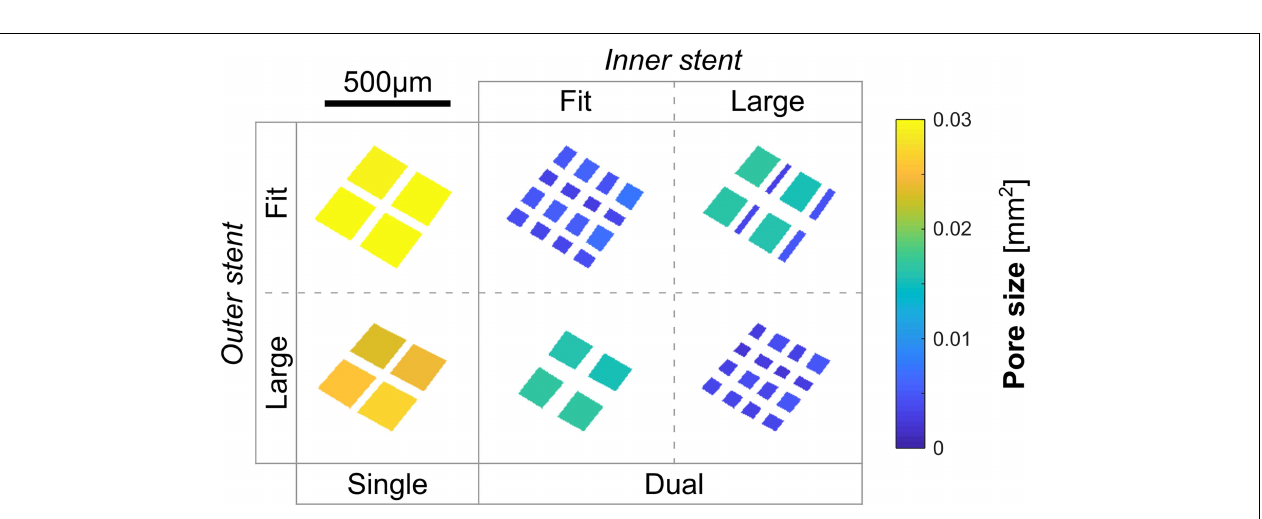
FIGURE 4 | The change in pore size (right) caused by deployment of a second stent shows good correlations ( r ≥ 0.50, all p < 0.001) with reductions of the post-treatment IR, aVEL, and aWSS, compared with the changes in porosity ( left , r < 0.15, all p > 0.24) and pore density (middle, r ≤ 0.21, all p > 0.10).